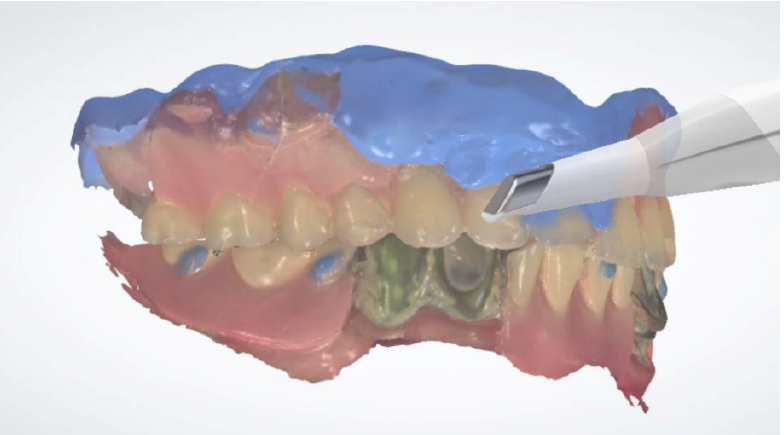
Figure 2. Scan the impression surface of the patient’s prostheses. The upper and lower occlusal relationships were scanned.